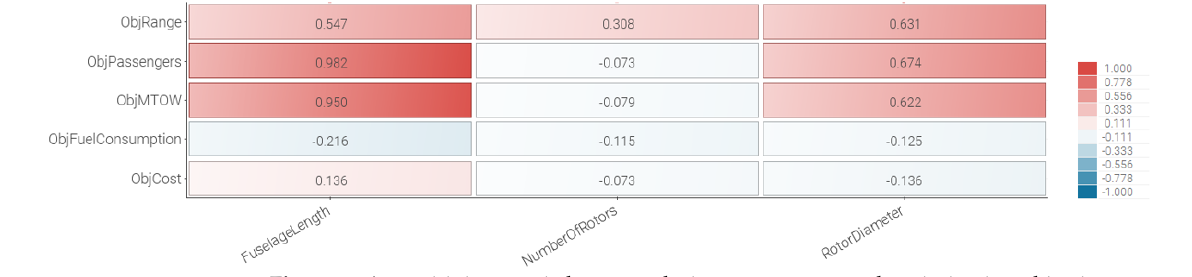
Figure 7. A sensitivity matrix between design parameters and optimization objectives.